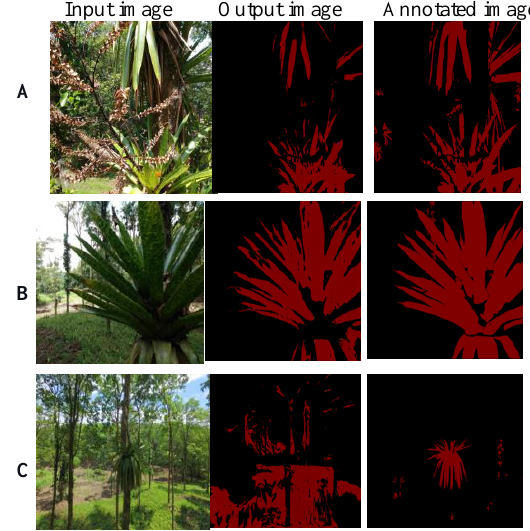
Figure 8. Three examples of when the output generated by the algorithm (middle column) failed to correctly identify the target plants as highlighted in the annotated image (right